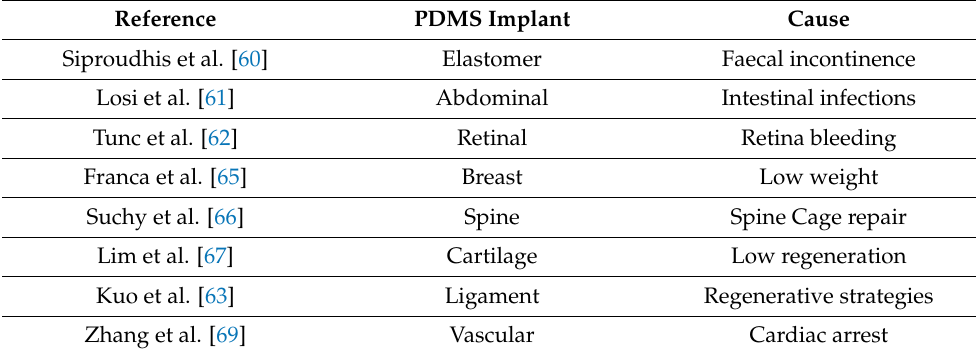
Table 2. Polydimethylsiloxane (PDMS)